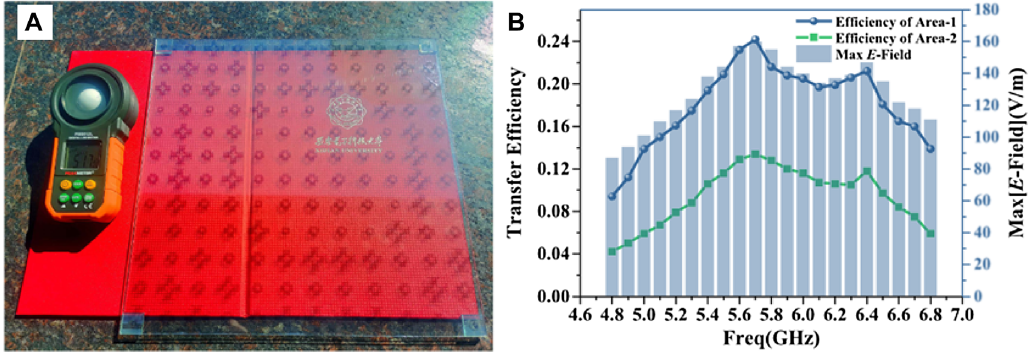
Figure 16: NFF transparent metasurface. (A) Transparent metasurface. (B) The NNF transmission efficiency [104]. Reprinted from [104], with the permission of IEEE